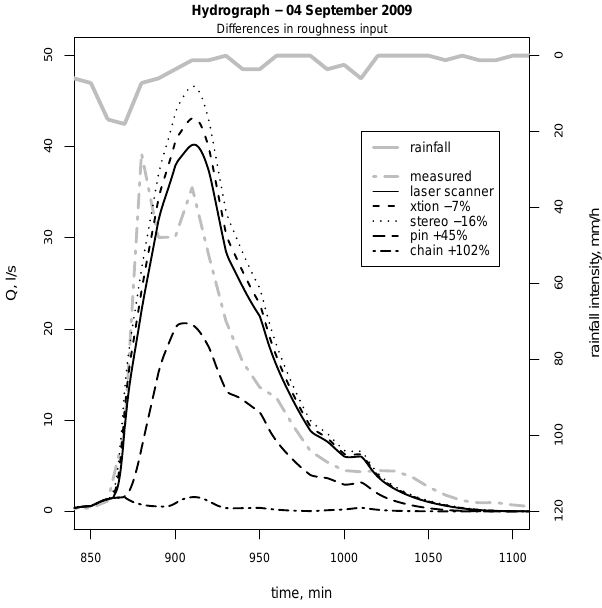
Figure 6. Model output as a function of mean RR values per method for harrowed